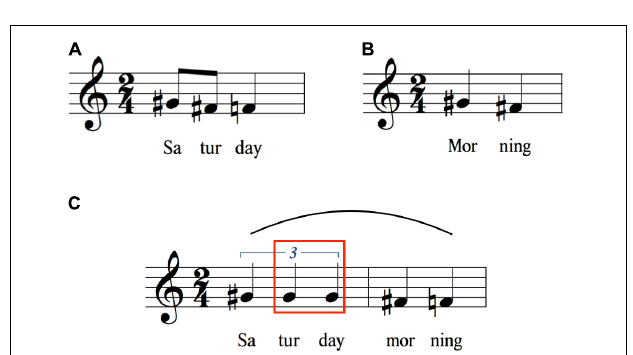
Frontiers in Psychology |